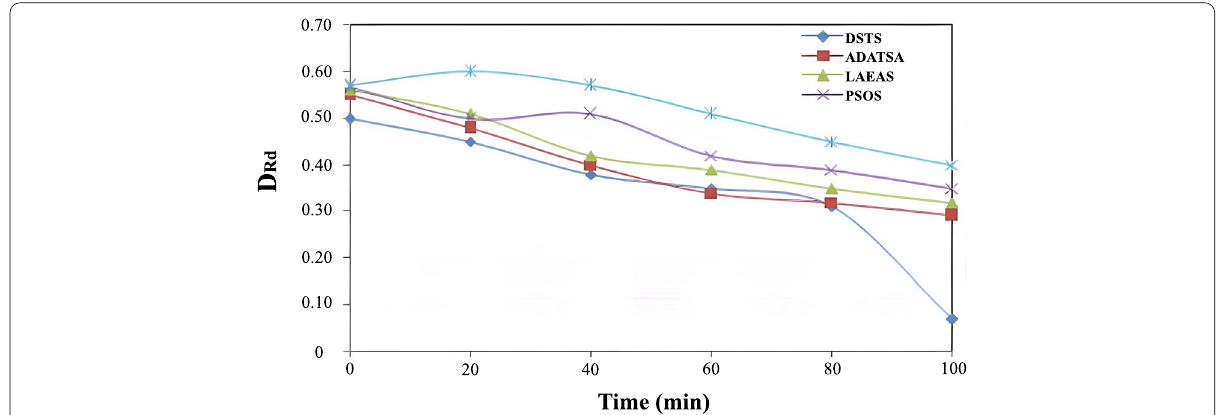
Fig. 11 Comparative analysis of resource residual degree (D Rd ) with time (Task-5)